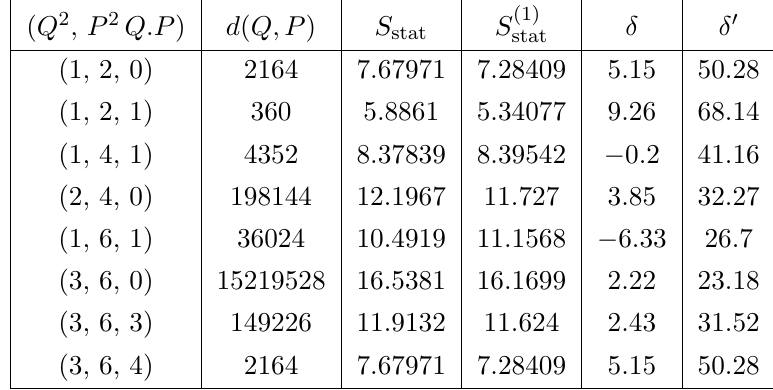
Table 5 . Comparison of the statistical entropy and statistical entropy at one loop for 2A orbifold.